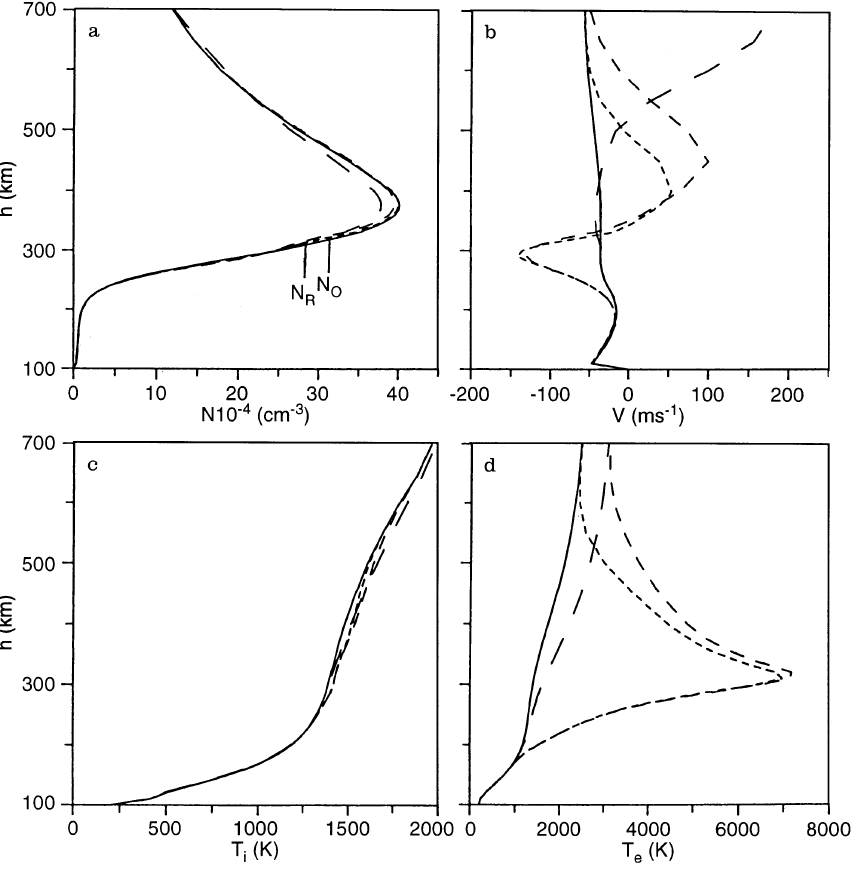
Fig. 3a (cid:177) d. Profiles versus distance from the earth, a along the geomagnetic field line of electron concentration, b parallel component of the positive ion velocity, c ion temperature, d electron temperature, at four distinct moments after turn on: 0 (——), 10 (----), 20 ( — — — — ), and 100 (— —)